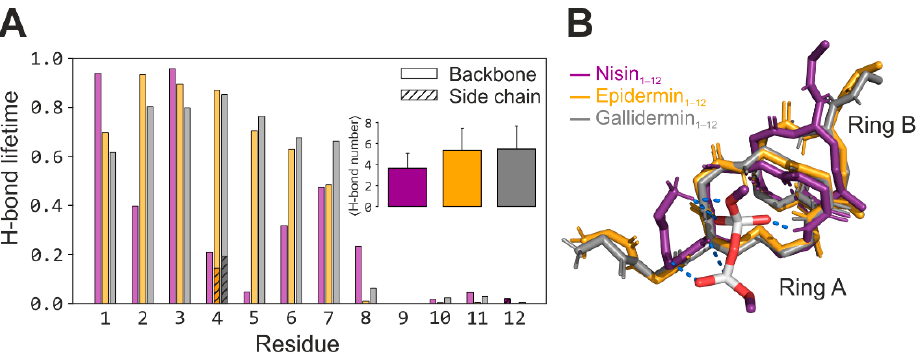
Figure 2. Binding modes of nisin, epidermin, and gallidermin to DMPPi revealed in MD simulations. ( A ) Intermolecular H-bonds lifetimes (as a fraction of MD time) per each residue. Note the contribution from the Lys 4 side chain for epidermin and gallidermin ( hatched bars ). Inset: average H-bonds number (±s.d.) over the whole peptides 1–12 in MD. ( B ) Representative structures of the most populated clusters. The structures are superimposed over the backbone of the residues 3–11. For clarity, only nisin-bound DMPPi is shown with sticks , wherein oxygen— red , phosphorus— white , carbon— purple ; peptides side chains and oxygen atoms are hidden. H-bonds are depicted with blue dotted lines